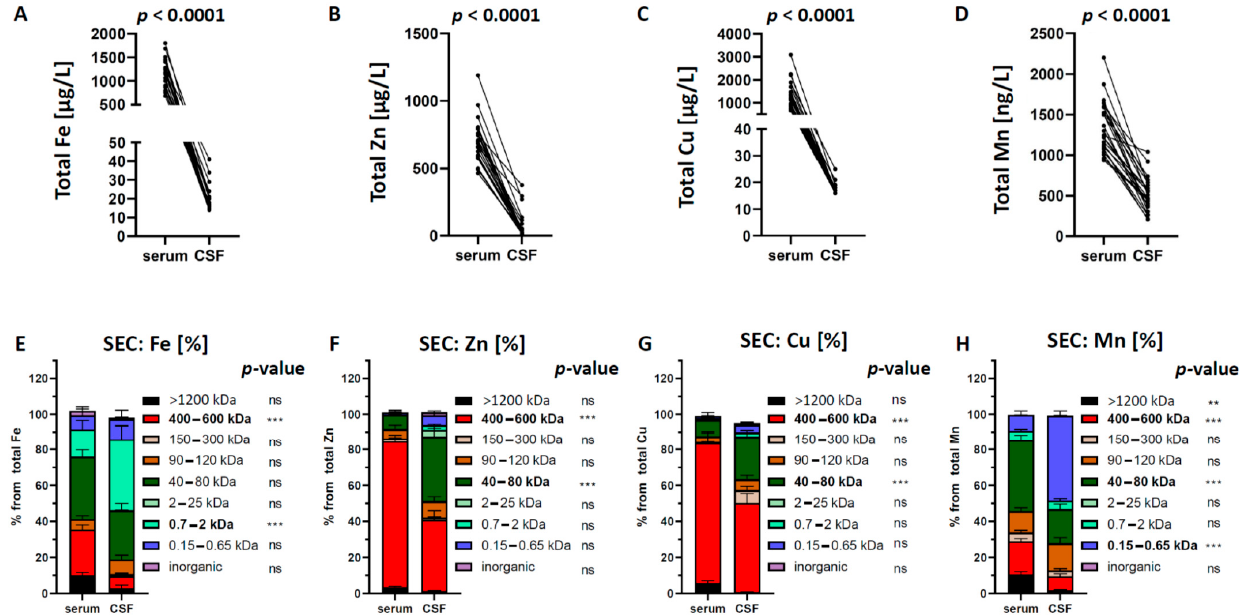
Figure 1. Changes of the total transition metal concentrations and of their relative distribution in size fractions from serum to corresponding CSF. ( A – D ) All four trace elements were significantly lower in CSF than in corresponding serum samples. ( E ) Changes of the Fe concentrations show a decrease for the 400–600 kDa and an increase for the 0.7–2 kDa fraction in CSF. ( F ) Changes of the Zn concentrations show a decrease for the 400–600 kDa and an increase for the 40–80 kDa fraction in CSF. ( G ) Changes of the Cu concentrations show a decrease for the 400–600 kDa and an increase for the 40–80 kDa fraction in CSF. ( H ) Changes of the Mn concentrations show a decrease for the >1200 kDa and the 400–600 kDa and an increase for the 0.15–0.65 kDa fraction in CSF. Differences were calculated using two-way ANOVA followed by Bonferroni post hoc analyses (** p < 0.01; *** p < 0.001). ns = not significant.